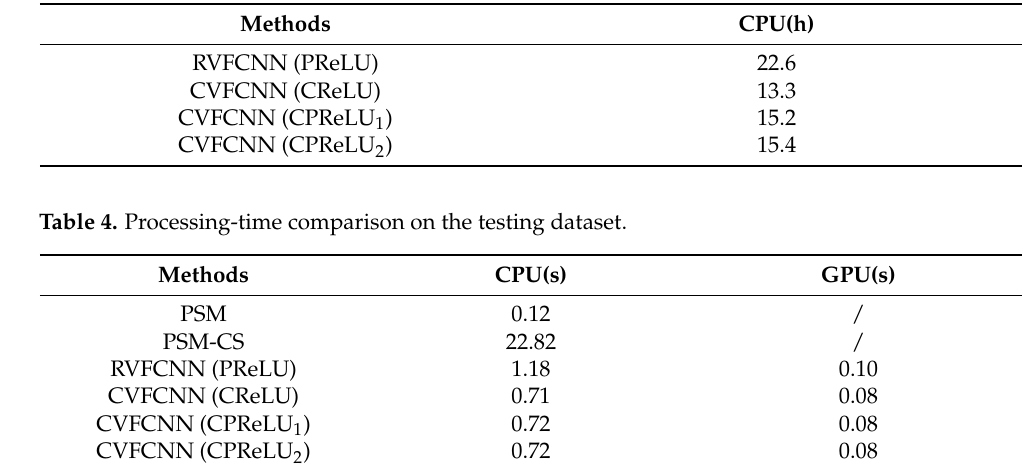
Table 3. Training-time comparison on the training dataset.